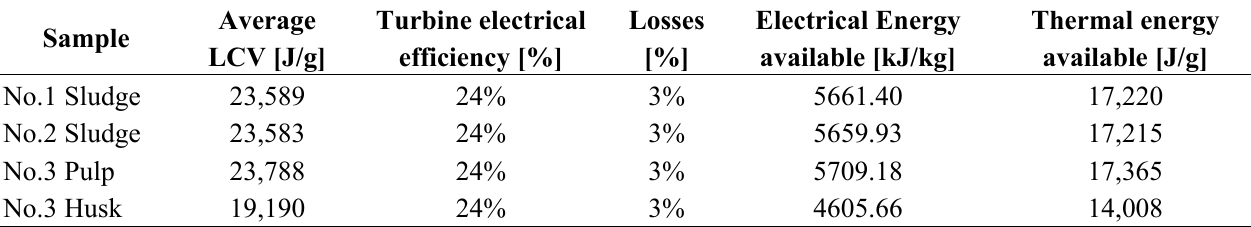
Table 8. Available electrical and thermal energy.